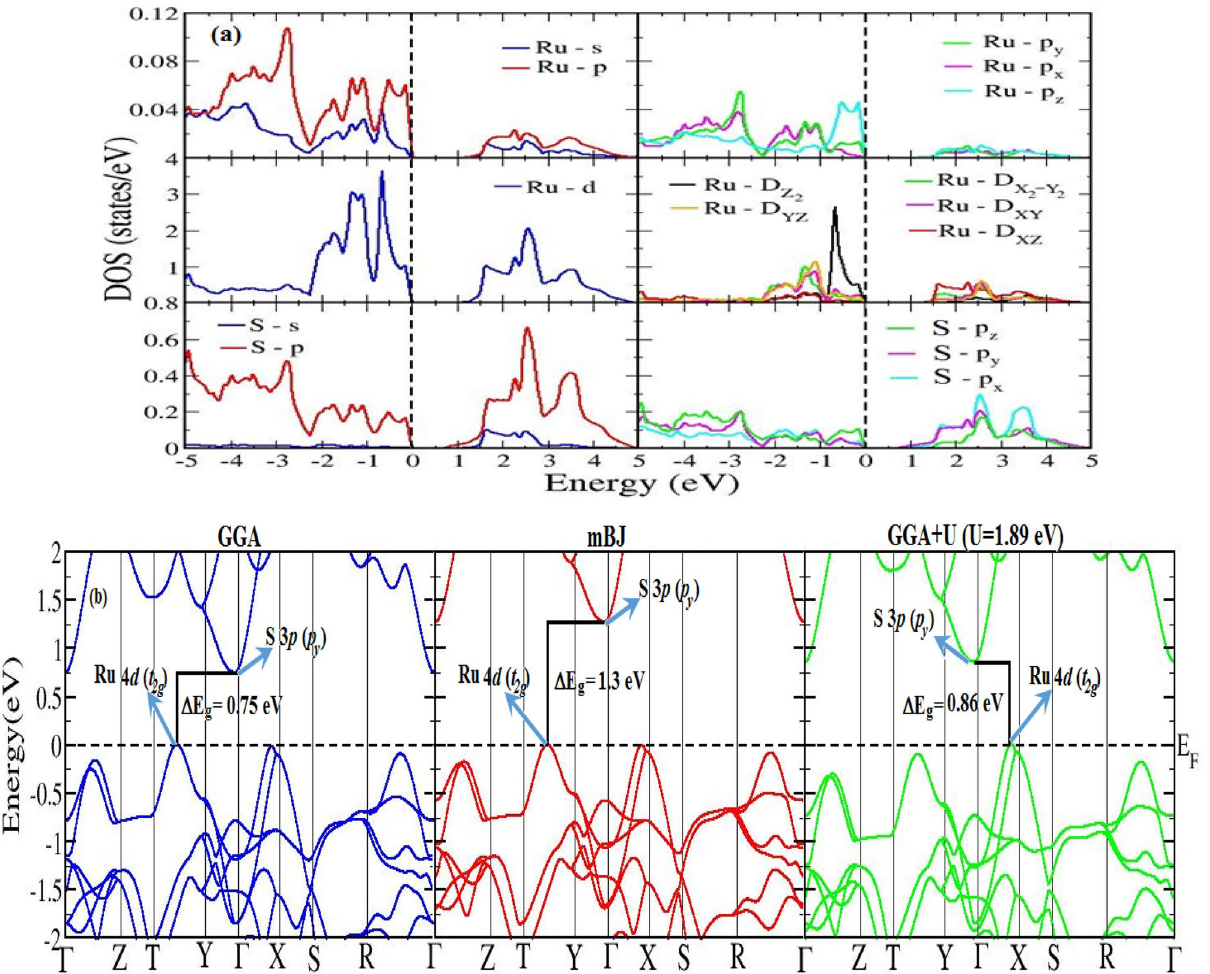
Figure 4. (a) Partial density of states for marcasite RuS 2 , showing different orbital contribution in the valence and conduction region. (b) Energy band structure of marcasite RuS 2 , with dominant orbital characteristics in the valence and conduction band edges. Note the shift in VBE under GGA + U